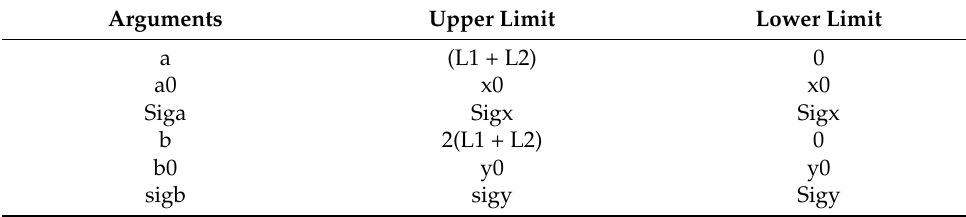
Table 2. Model arguments with limits.